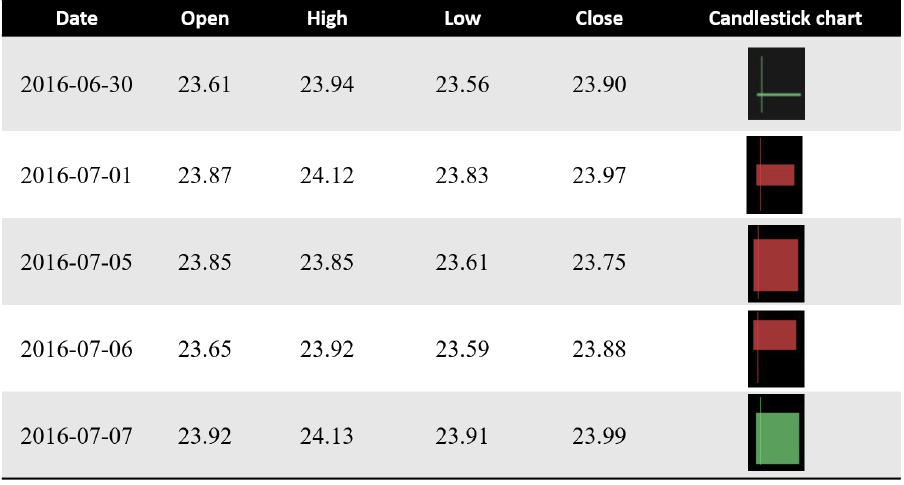
Figure 6. A view of candlestick chart data for stock price movement